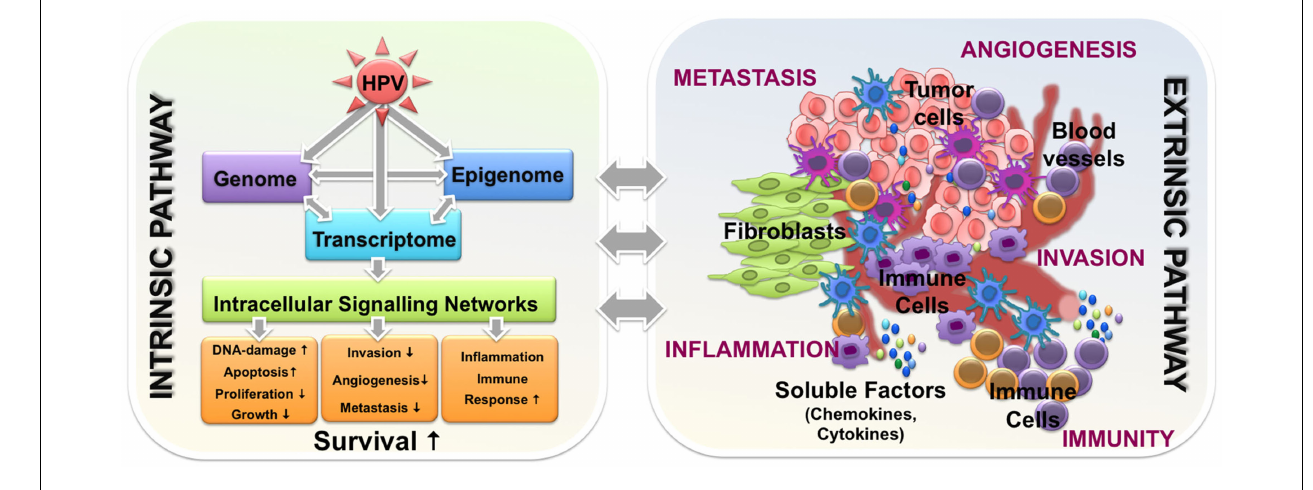
transcriptome.These events drive alternations in intracellular signaling networks and along with complex interactions of malignant cells with components of tumor microenvironment including immune cells, they orchestrate the improved response to treatment and the favorable